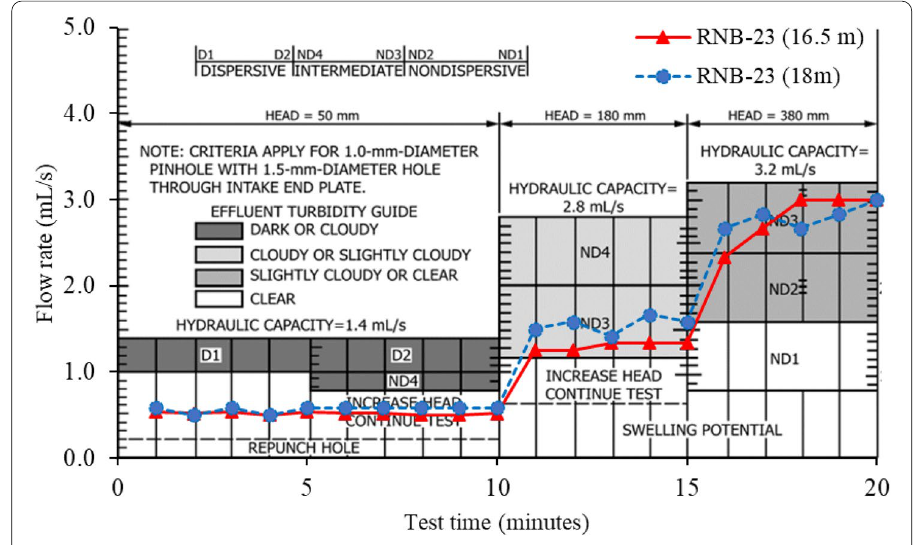
Fig. 9 Flow rate and dispersive grade of clay